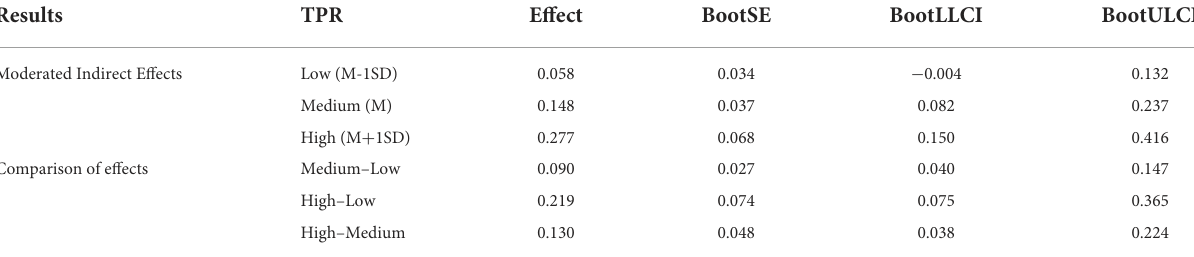
TABLE 9 Bootstrapping test of moderated indirect